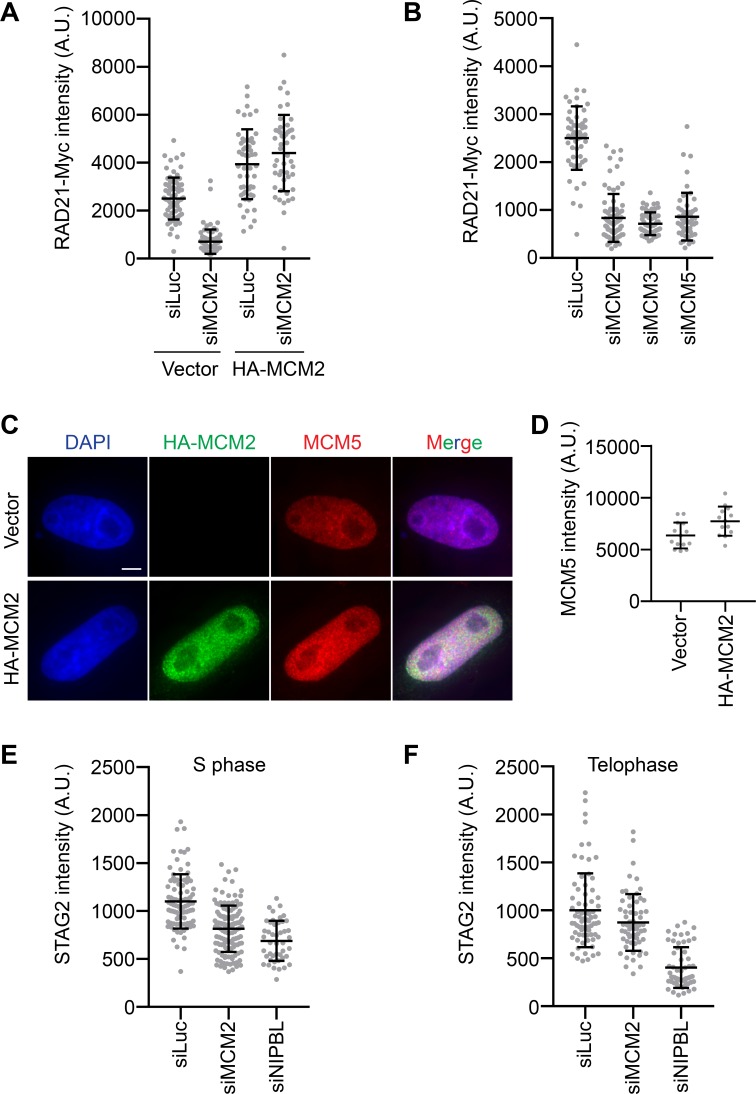
MCM2–7 promotes cohesin loading in early S phase human cells.(A) Quantification of the intensities of chromatin-bound RAD21-Myc in HeLa cells transfected with the indicated plasmids and siRNAs and synchronized in early S phase by thymidine. Each dot in the graph represents a single cell. Mean ± SD (Vector + siLuc, n = 73; Vector + siMCM2, n = 77; HA-MCM2 + siLuc, n = 52; HA-MCM2 +siMCM2, n = 48). (B) Quantification of the intensities of chromatin-bound RAD21-Myc in HeLa cells transfected with the indicated siRNAs and synchronized in early S phase by thymidine. Each dot in the graph represents a single cell. Mean ± SD (siLuc, n = 55; siMCM2, n = 78; siMCM3, n = 57; siMCM5, n = 51). (C) DAPI (blue), anti-HA (green), and anti-MCM5 (red) staining of HeLa cells transfected with vector or HA-MCM2. Scale bar, 5 μm. (D) Quantification of MCM5 intensities on chromatin of cells in C). Each dot in the graph represents a single cell. Mean ± SD (Vector, n = 14; HA-MCM2, n = 13). (E) Quantification of the STAG2 intensities on chromatin in HeLa cells transfected with the indicated siRNAs and synchronized in early S phase by thymidine. Each dot in the graph represents a single cell. Mean ± SD (siLuc, n = 89; siMCM2, n = 130; siNIPBL, n = 45). (F) Quantification of the STAG2 intensities on chromatin in telophase HeLa cells transfected with the indicated siRNAs. Each dot in the graph represents a single cell. Mean ± SD (siLuc, n = 74; siMCM2, n = 61; siNIPBL, n = 58).